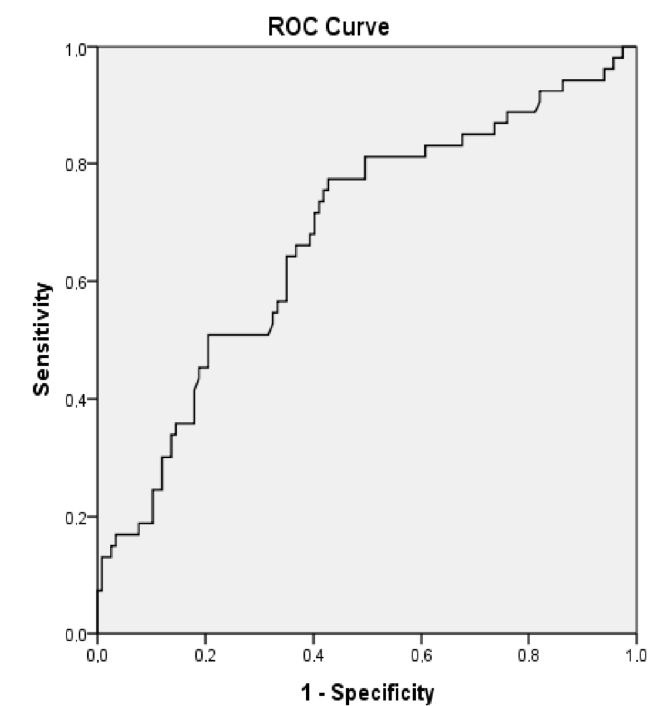
Figure 2. A receiver operating characteristic curve analyses of uric acid/albumin ratio (UAR).